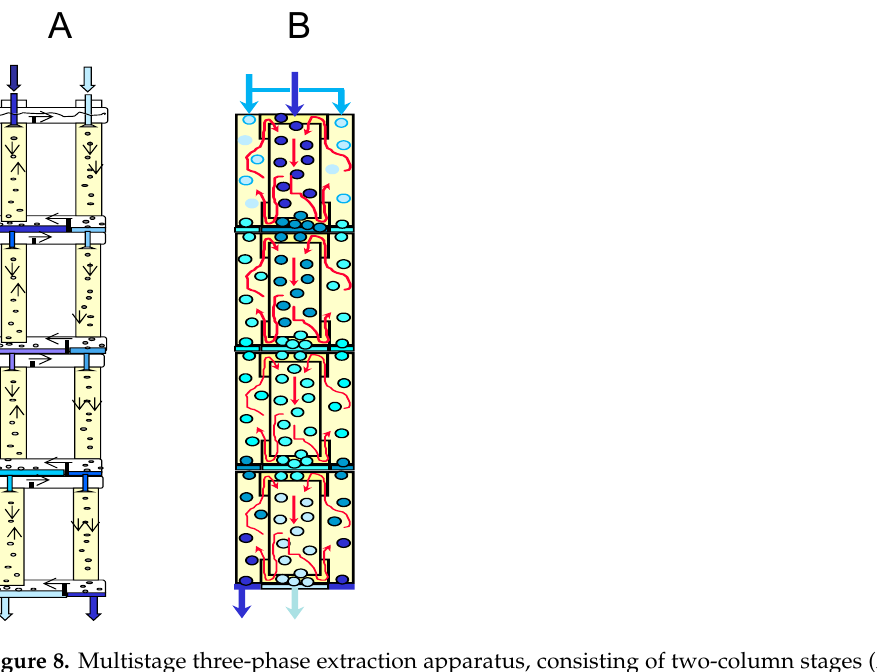
Figure 7. The process of multistage three-phase extraction separation in a cascade of two-column three-phase apparatuses with recirculation of the stripping phase at each stage.